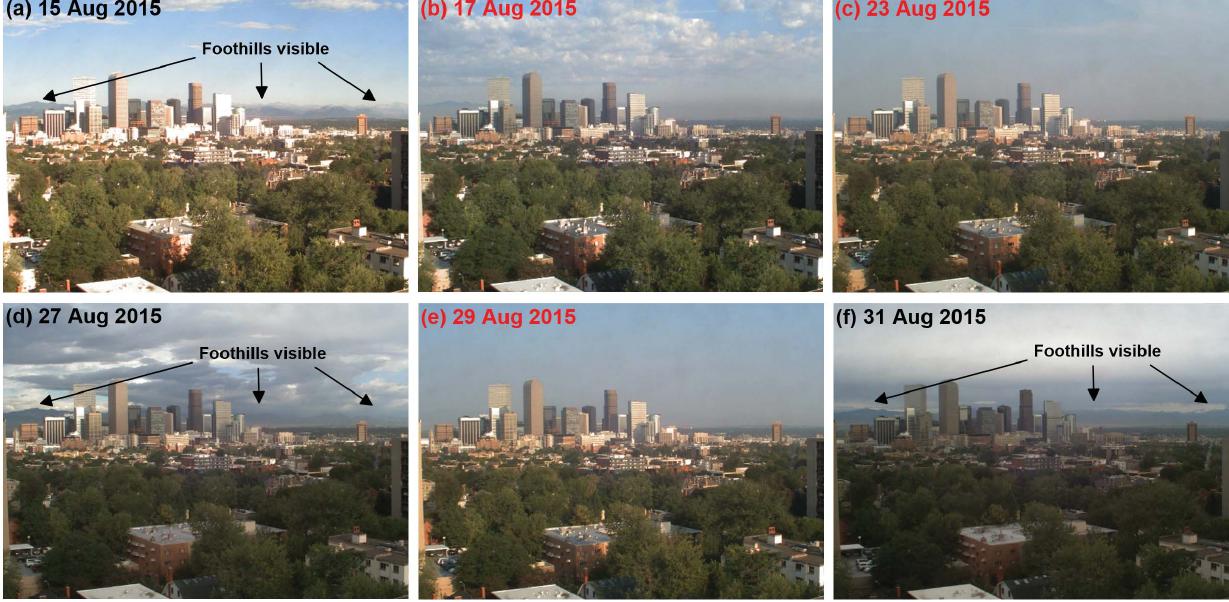
Figure 2. Images of downtown Denver facing west taken at 14:00UTC (08:00MDT). Images acquired from the CDPHE Visibility Station (DESCI; 39.73 ◦ N, 104.96 ◦ W; 1633ma.m.s.l.). Only days of significant meteorological and visibility transitions in August 2015 are shown. Days in red are those which correspond to the haziest days during the study time period. In panels (a) , (d) , and (f) , the visibility of the foothills (and background high terrain) is